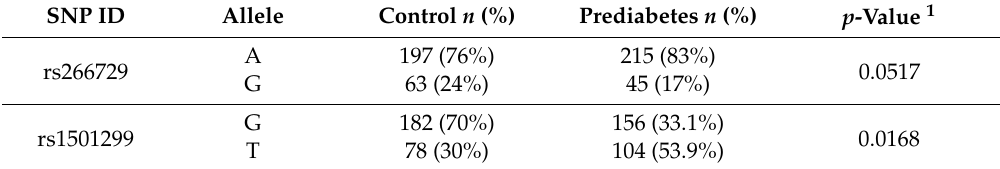
Table 5. Allele frequencies of rs266729, rs1501299 and rs2241766 SNPs in control and prediabetic